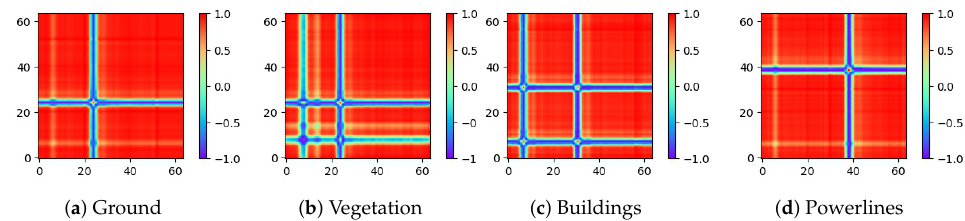
Figure 6. Diagram of different transform methods used for the urban waveform.